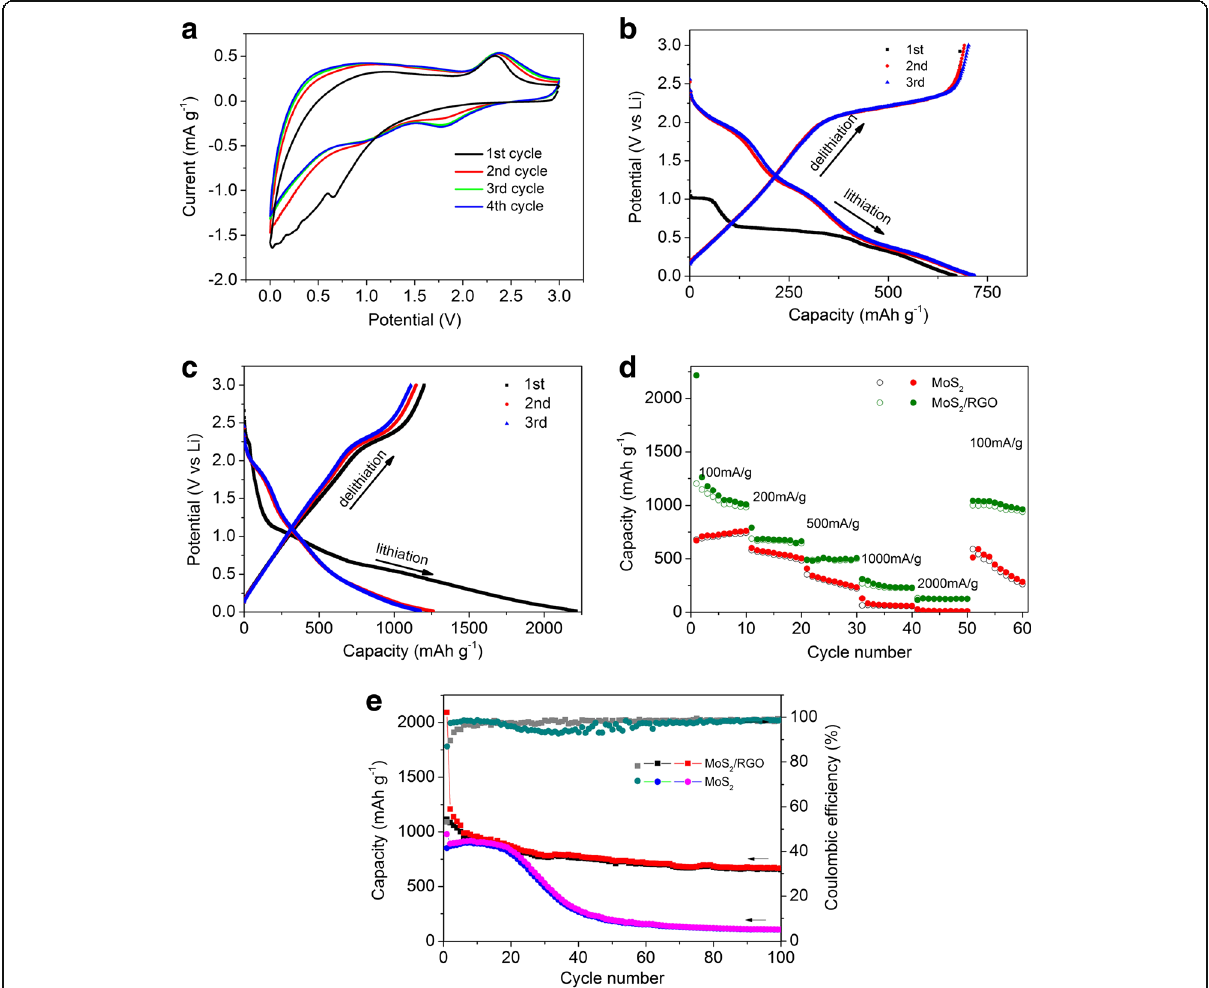
Fig. 4 The first three cyclic voltammograms of MoS2/RGO aerogel at a scan rate of 0.5mV s-1 ( a ). Galvanostatic charge and discharge curves of MoS2/RGO aerogel ( b ) and MoS2 ( c ) electrodes at a current density of 100mA g-1. d Rate performances of MoS2/RGO aerogel and MoS2 electrodes at different current densities. e Cycling performance of MoS2/RGO aerogel and MoS2 electrodes at a constant current density of 100mA